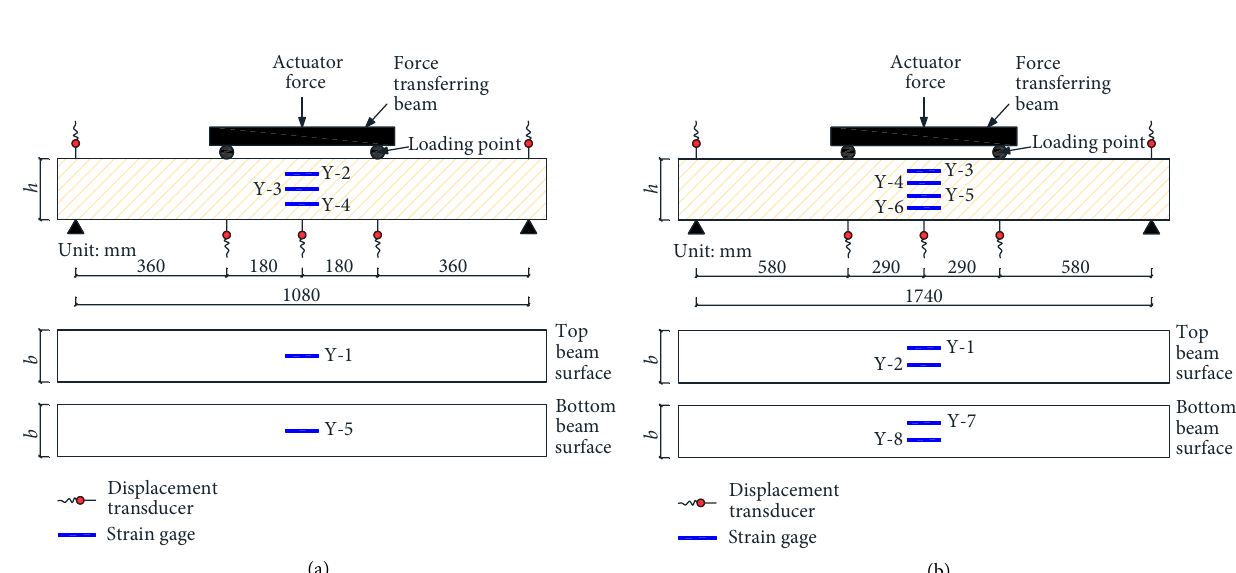
Figure 5: Test setup.